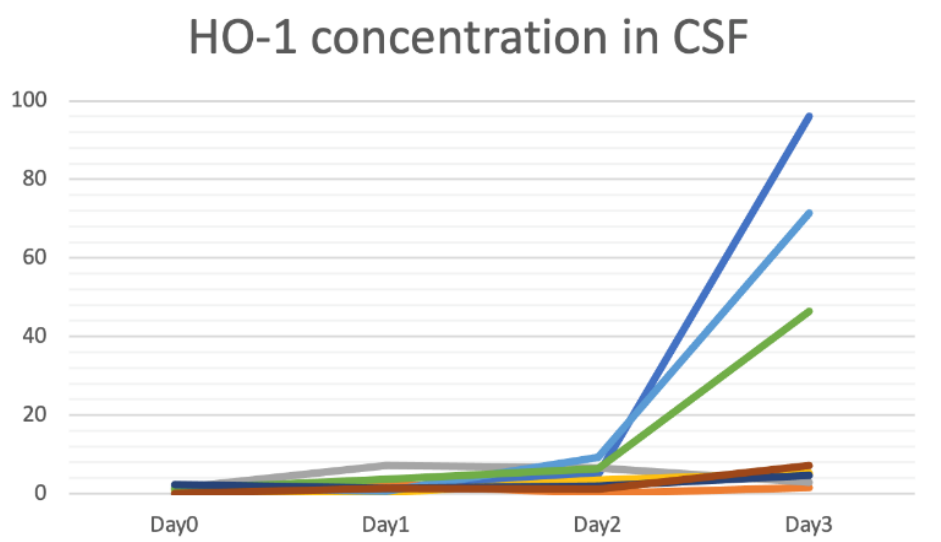
Figure 5. Trends of heme oxygenase (HO)-1 concentration in cerebrospinal fluid (CSF) from recruited spontaneous subarachnoid hemorrhage (SAH) patients. ( x -axis: days from ictus; y -axis: HO-1 concentration in CSF (ng/mL)). (Data from ELISA).